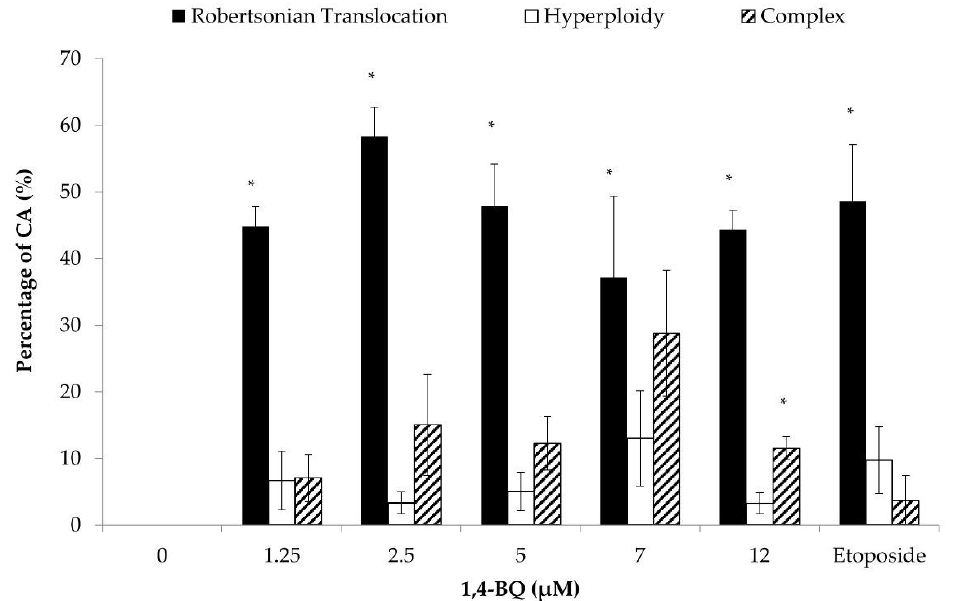
Figure 8. Effect of 1,4-BQ on different types of CA (Rb, hyperploidy, and complex) in Pre-B lymphoid progenitor cells harvested after 7 days of CFU assay following pre-exposure of MBMCs to 1,4-BQ for 24 h. Twenty metaphases were scored for each experimental group and the percentage of each type of CA is as presented. Data are presented as the mean ± S.E.M. ( n = 3) and analyzed by using one-way ANOVA. * p < 0.05 compared with the negative control group.